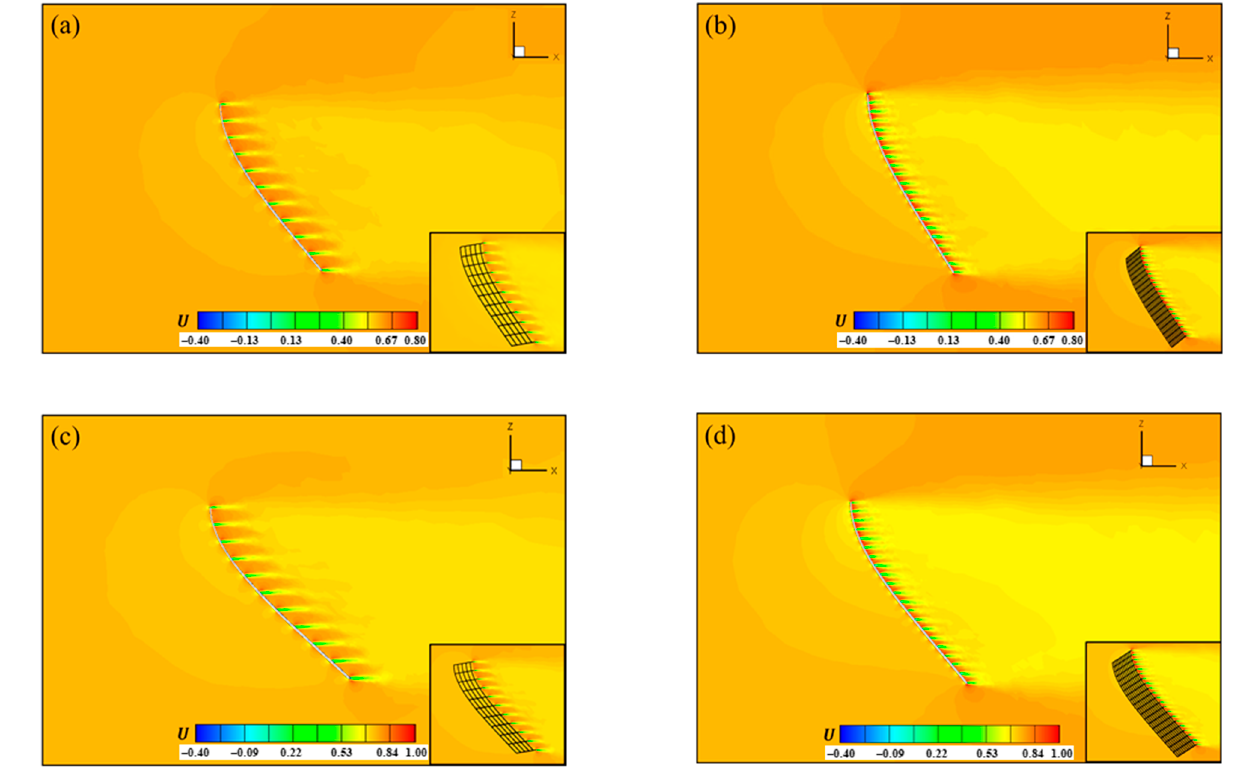
Figure 5. Velocity distributions of the flow at the angles of attack between π/3 and π/2 for net solidities 𝑆𝑛 = 0.16 (left column) and 𝑆𝑛 = 0.33 (right column): ( a , b ) 𝑈 (cid:2998) = 0.15 m/s; ( c , d ) 𝑈 (cid:2998) = 0.30 m/s; ( e , f ) 𝑈 (cid:2998) = 0.45 m/s.